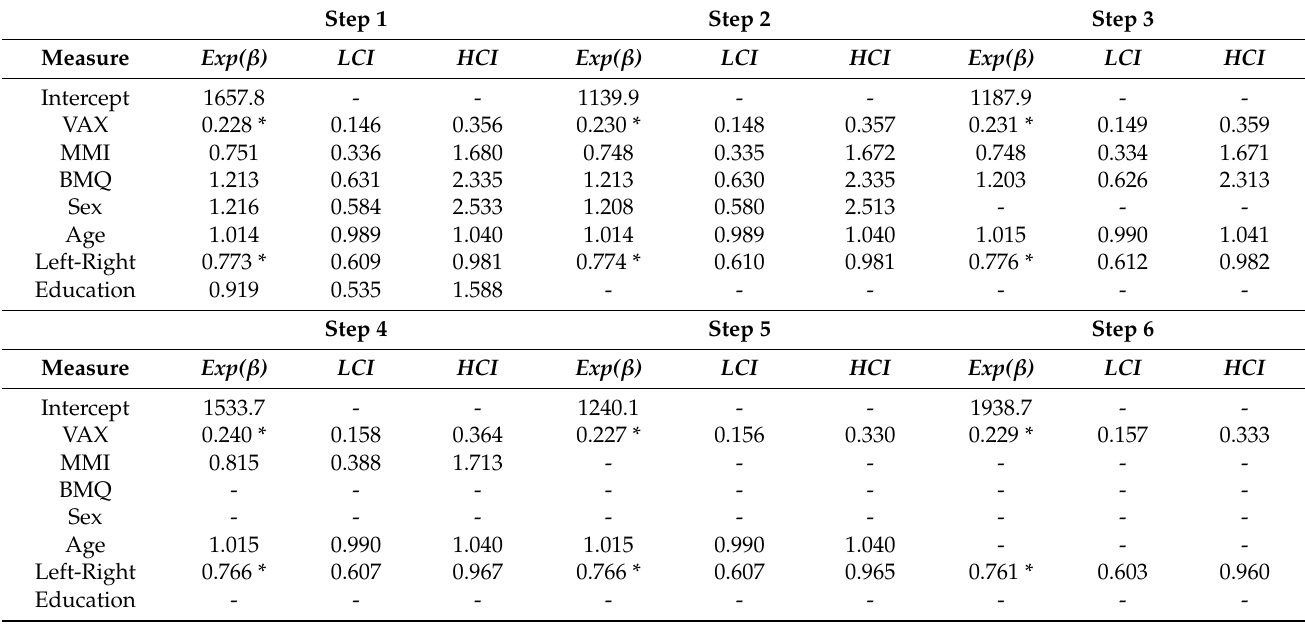
Table 9. Study 2. Summary of stepwise logistic binary regression to predict COVID-19 vaccination. *: p < 0.05. LCI: